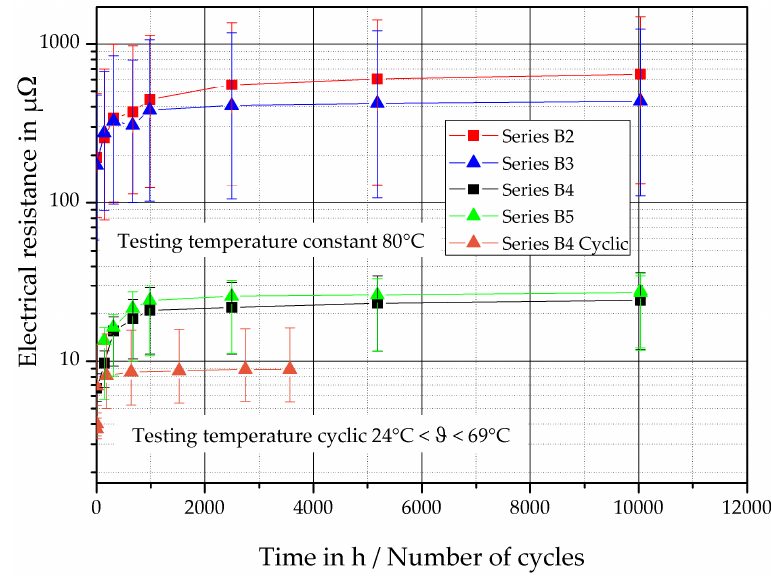
Figure 9. Electrical resistance (R V1 ) depends on the time in a heating cabinet at 80 °C (continuous load) and cyclic load.